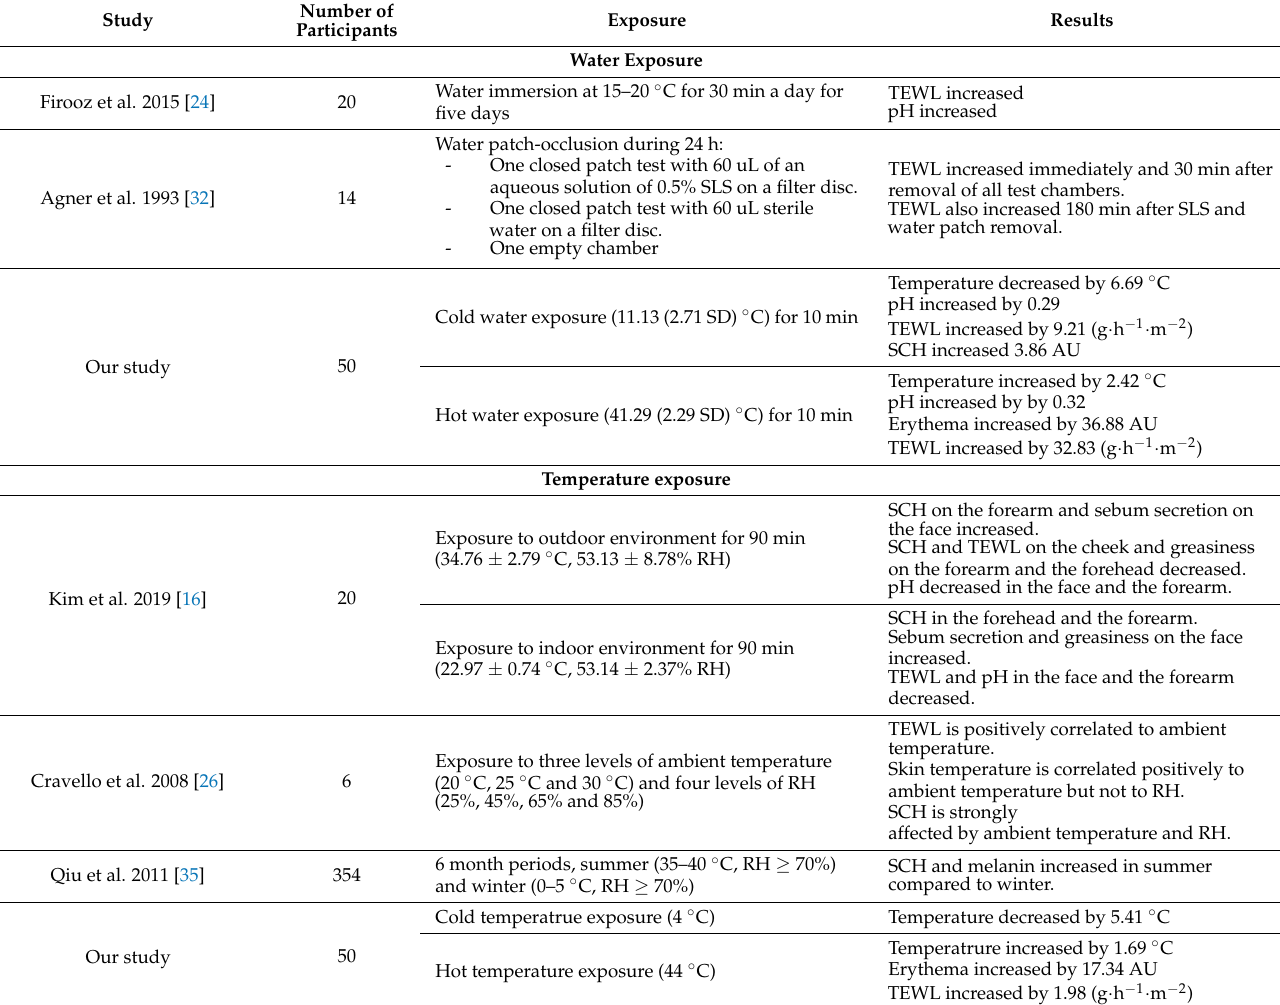
Table 4. Studies evaluating water and temperature